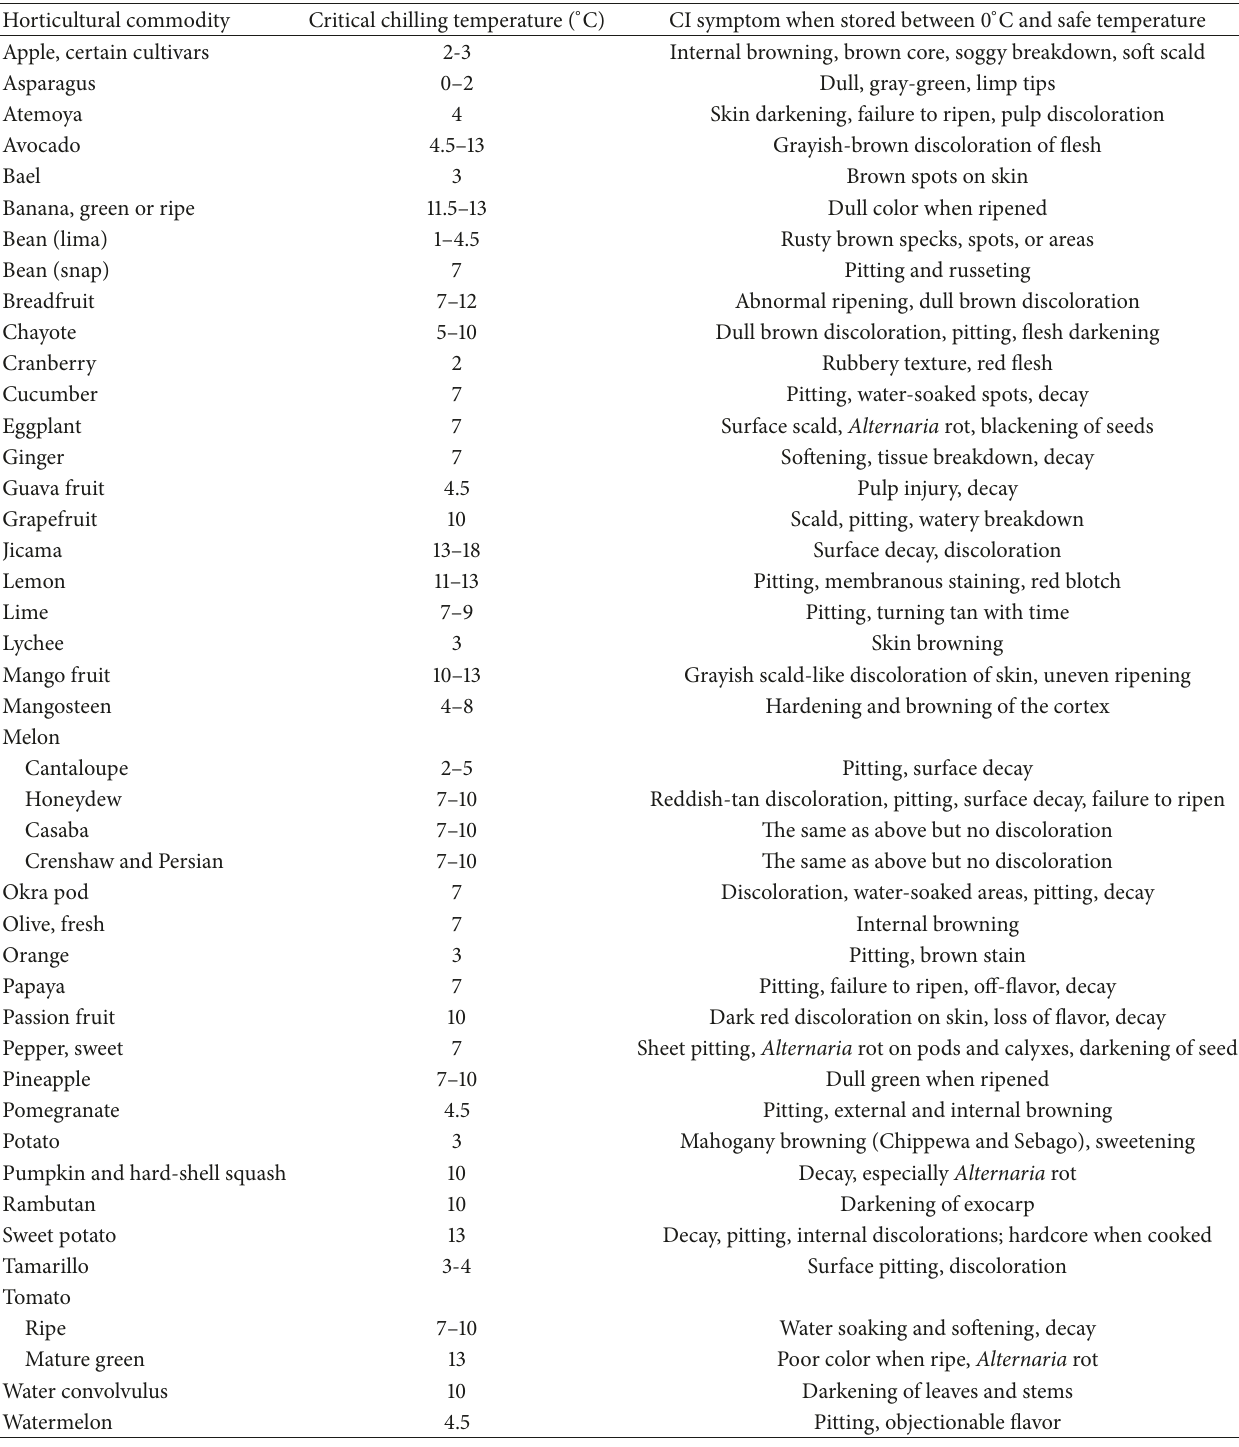
Table 1: Chilling injury (CI) symptoms of several horticultural commodities with their critical chilling temperatures